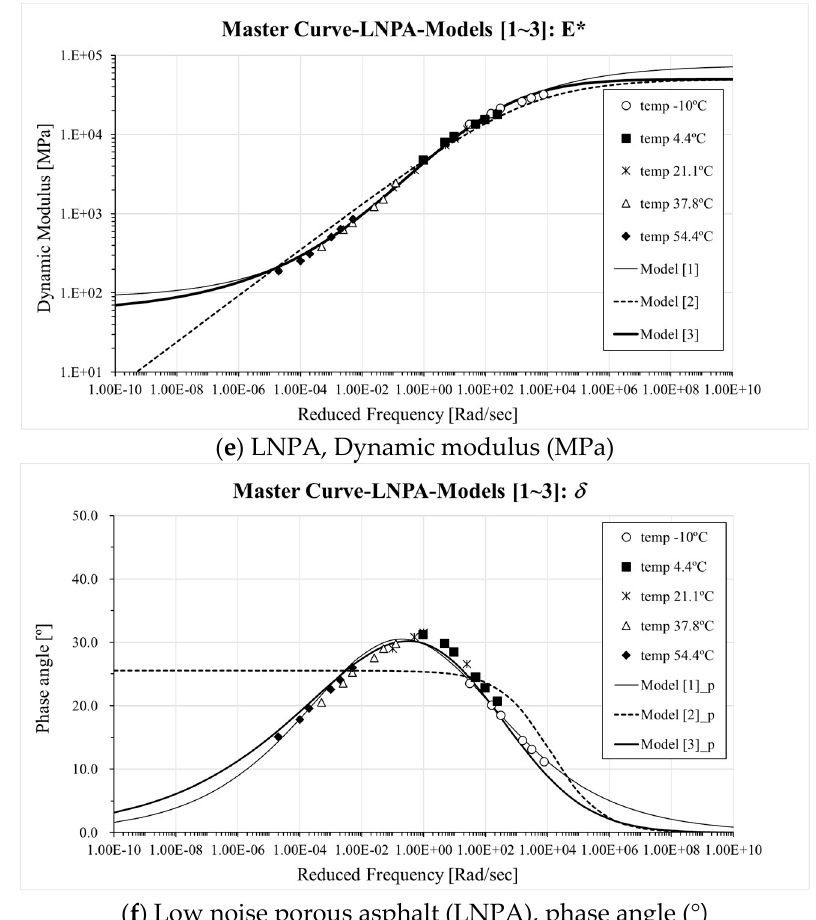
Figure 3. |E*( ω )| and δ ( ω ) master curves of Mixtures (( a , b ) HMA, ( c , d ) SMA, ( e , f ) LNPA).